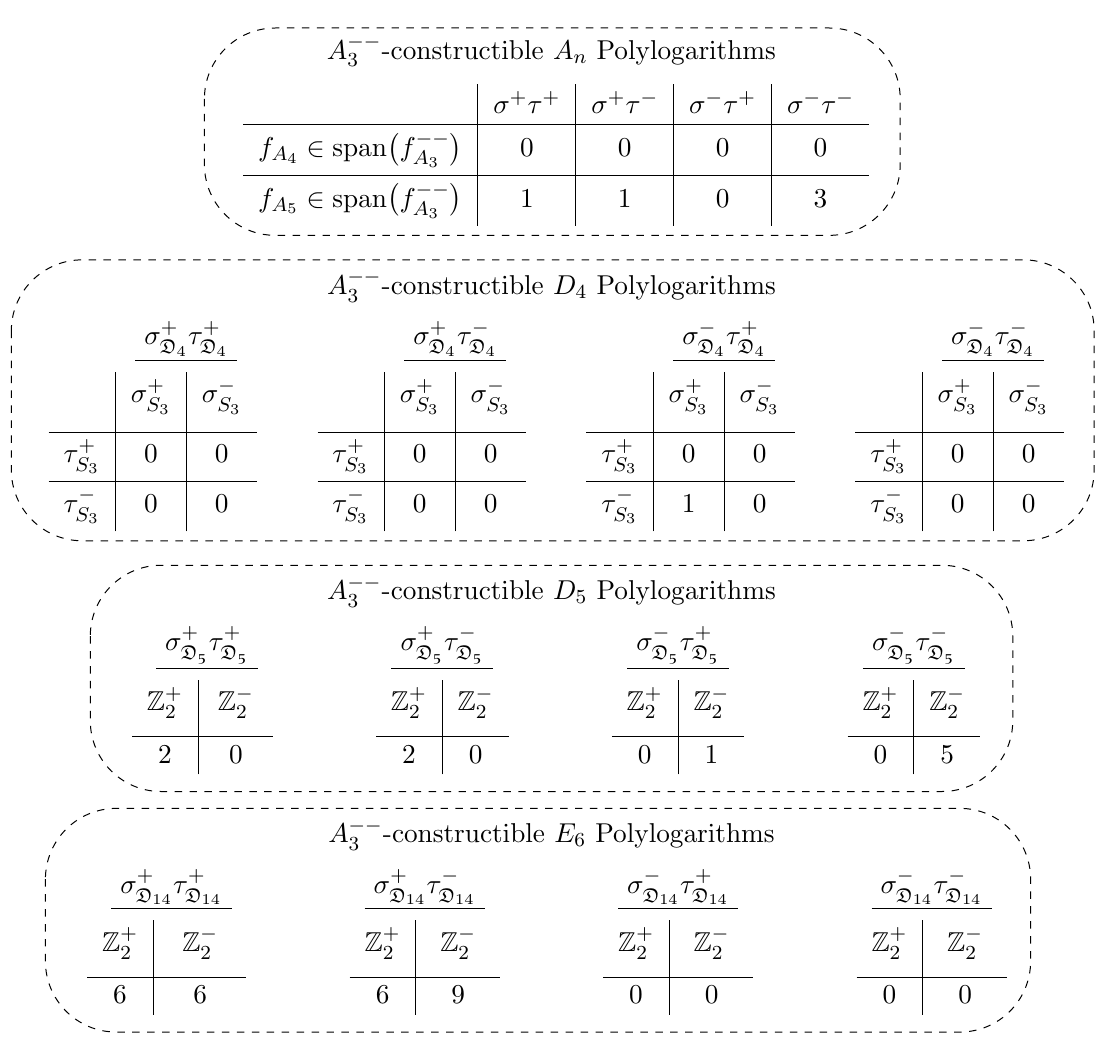
cluster algebra and 6